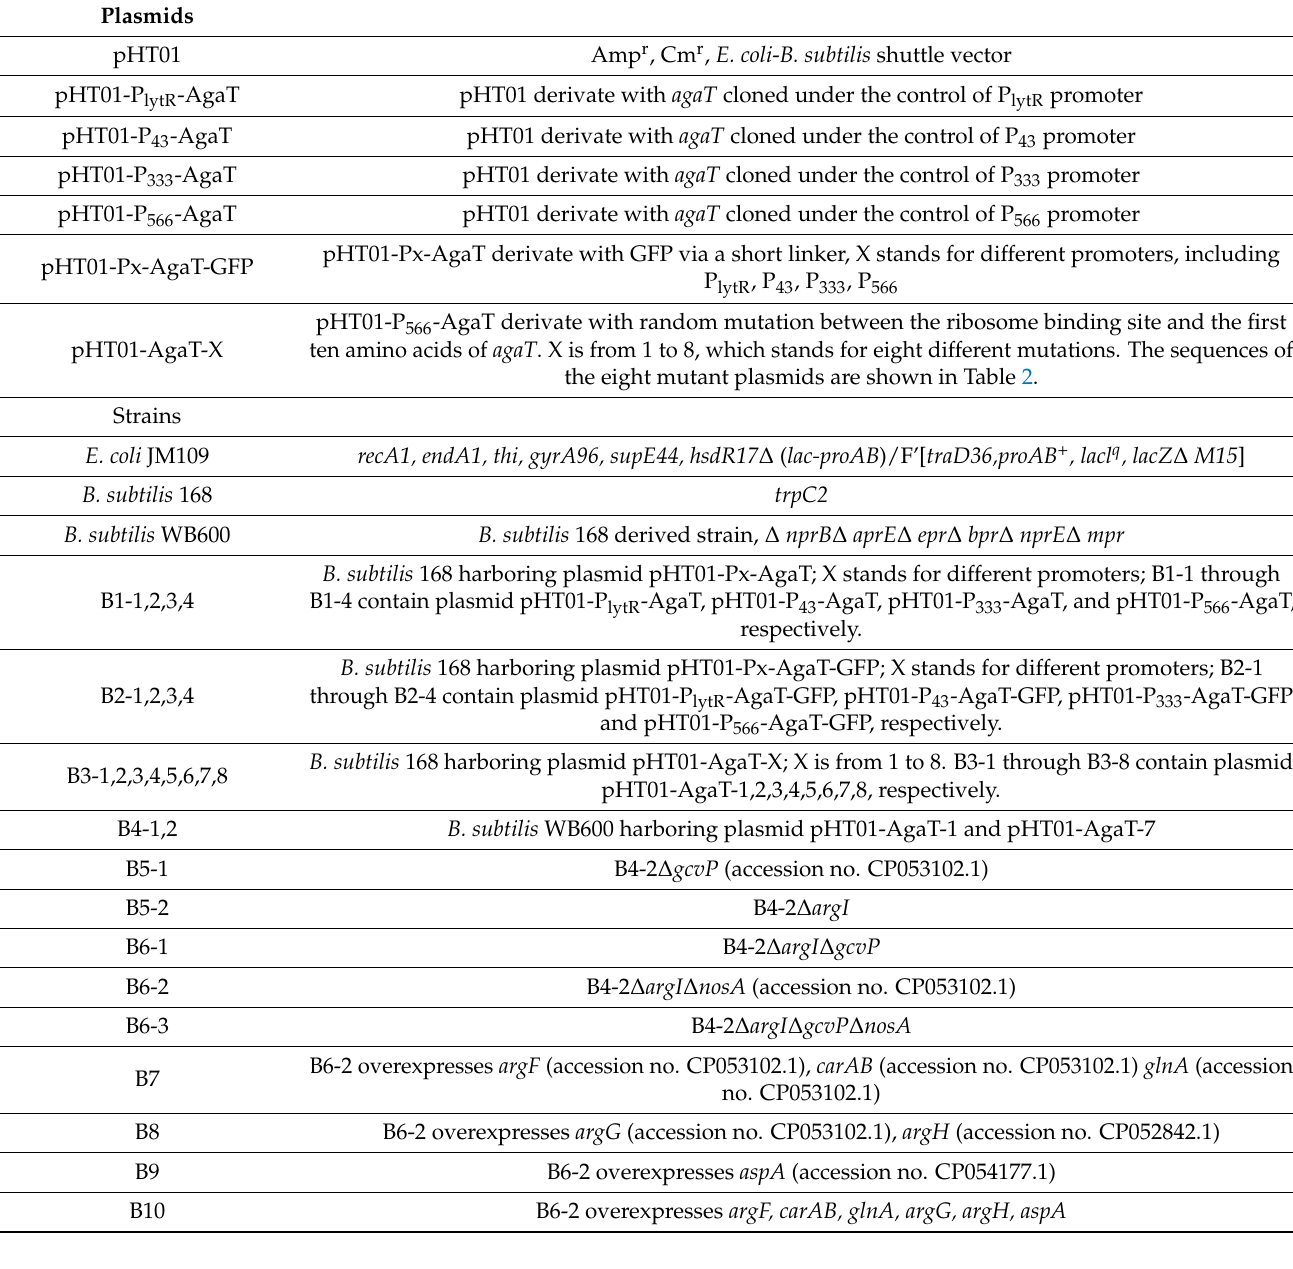
Table 1. Strains and plasmids used in this